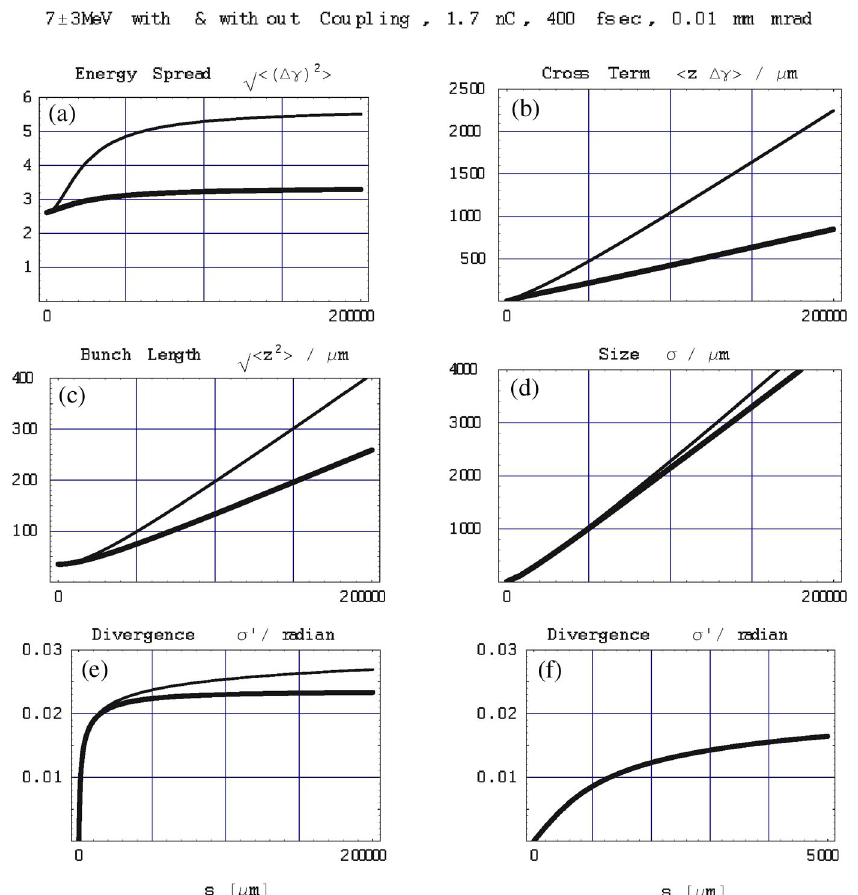
FIG. 1. (Color) Calculated longitudinal and transverse phase space evolution for coupled (thick line) and uncoupled (thin line) theory. The parameters were taken from [1,2] with (cid:1)(cid:1)(cid:1)(cid:1)(cid:1)(cid:1)(cid:1)(cid:1)(cid:1)(cid:1)(cid:1)(cid:1)(cid:1)(cid:1)(cid:1) p h (cid:8) 2 i(cid:6) s (cid:7) , charge of N (cid:3) 1 (cid:1) 10 10 . All parameters are shown vs the drift length s (in (cid:4) m ): (a) p (cid:1)(cid:1)(cid:1)(cid:1)(cid:1)(cid:1)(cid:1)(cid:1)(cid:1)(cid:1)(cid:1)(cid:1)(cid:1)(cid:1) h z 2 i(cid:6) s (cid:7) , (d) (cid:2) (cid:6) s (cid:7) , and (e),(f) (cid:2) 0 (cid:6) s (cid:7) . The sixth figure (f) is the same (cid:2) 0 of the (b) h z(cid:8) i(cid:6) s (cid:7) , (c) fifth (e), except that (f) is plotted for a shorter range in s to emphasize the initial short range development. Initial condition for (cid:2) is (cid:2) (cid:6) 0 (cid:7) (cid:3) 5 (cid:4) m , as taken from the typical size of the laser-plasma channel. We assume (cid:2) 0 (cid:6) 0 (cid:7) (cid:3) 0 , i.e., there is a beam waist at the plasma exit; calculations with (cid:2) 0 (cid:6) 0 (cid:7) significantly different from 0 do not match the experimental findings. All units for z , (cid:2) , and s are in microns, units of divergence (cid:2) 0 (cid:6) s (cid:7) are in radian, the unit for we choose 0.01 mm mrad energy related parameters is (cid:9) . For initial ‘‘intrinsic’’ emittance (cid:1) 0 (geometric emittance) because this was the largest emittance we could use and still reproduce the experimental results with our theory, see Fig. 3, although the experiments are also reproduced with smaller emittances. Note that the drift is plotted out to 20 cm to match the experimental setup of [1], and that acceleration has not been